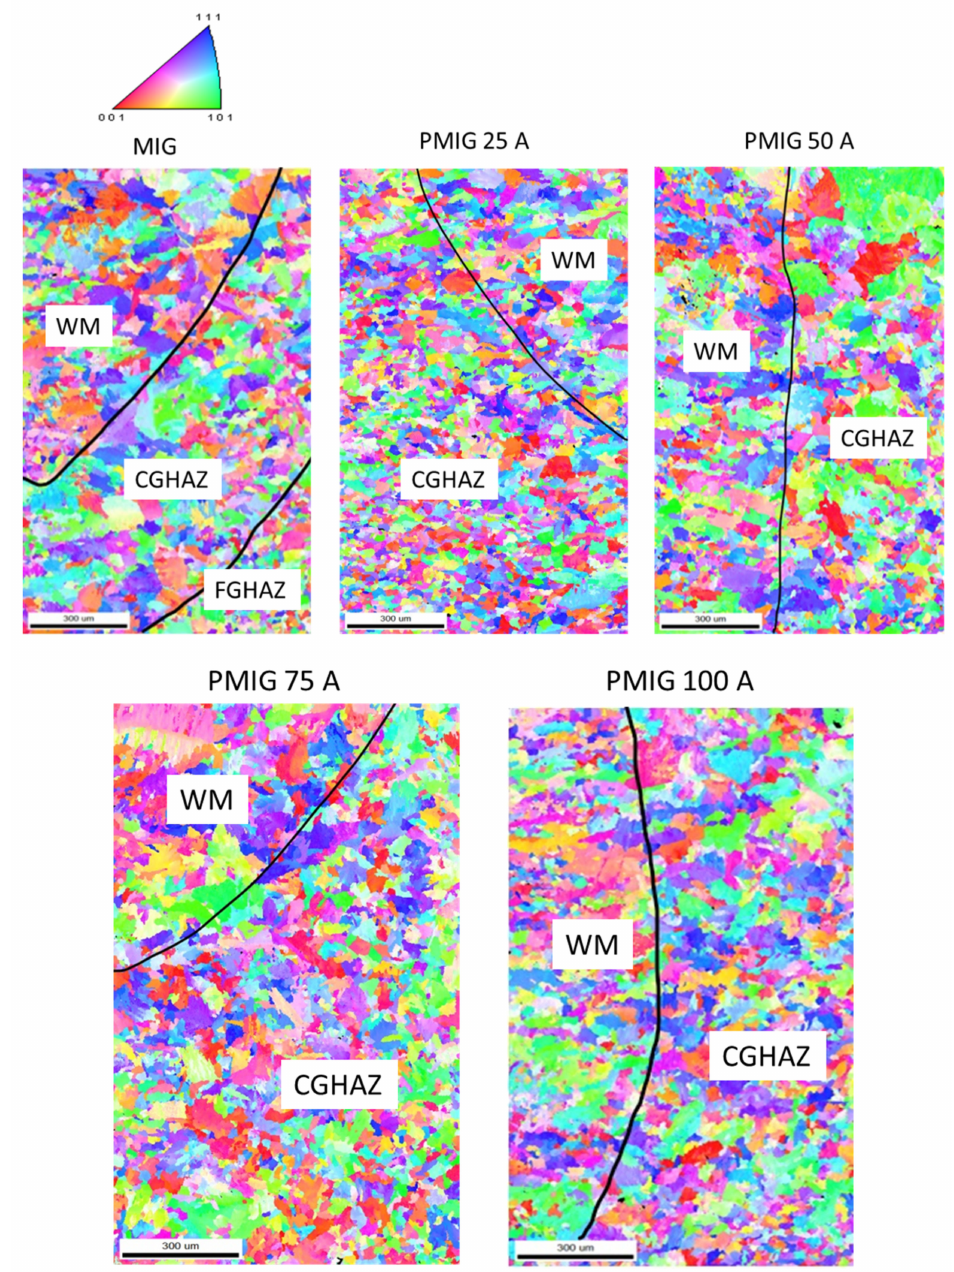
Figure 5. IPF maps of the specimen welded by different plasma currents (0, 25, 50 and 100 A) using plasma MIG